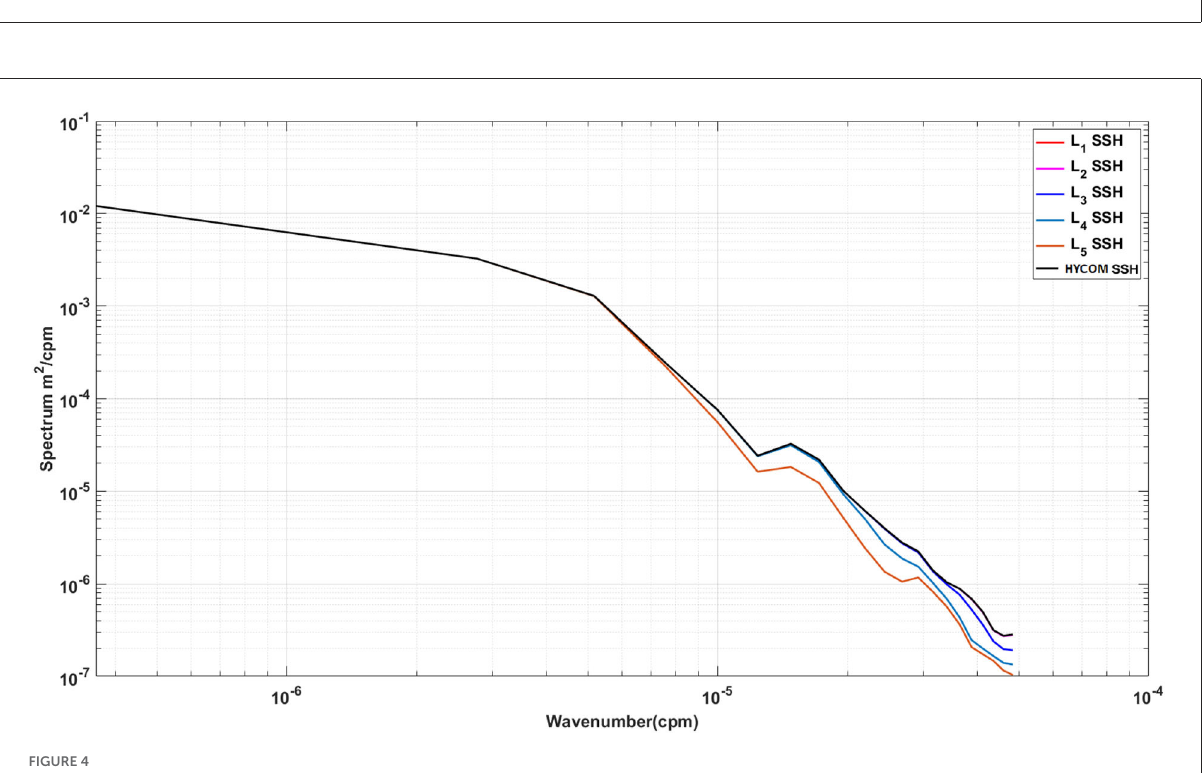
FIGURE3 Model domain overlaid with SSH in meters. The black rectangle shows the region of interest (ROI) described in the text. The crosses mark the reference points used to measure the SSH prediction accuracy.